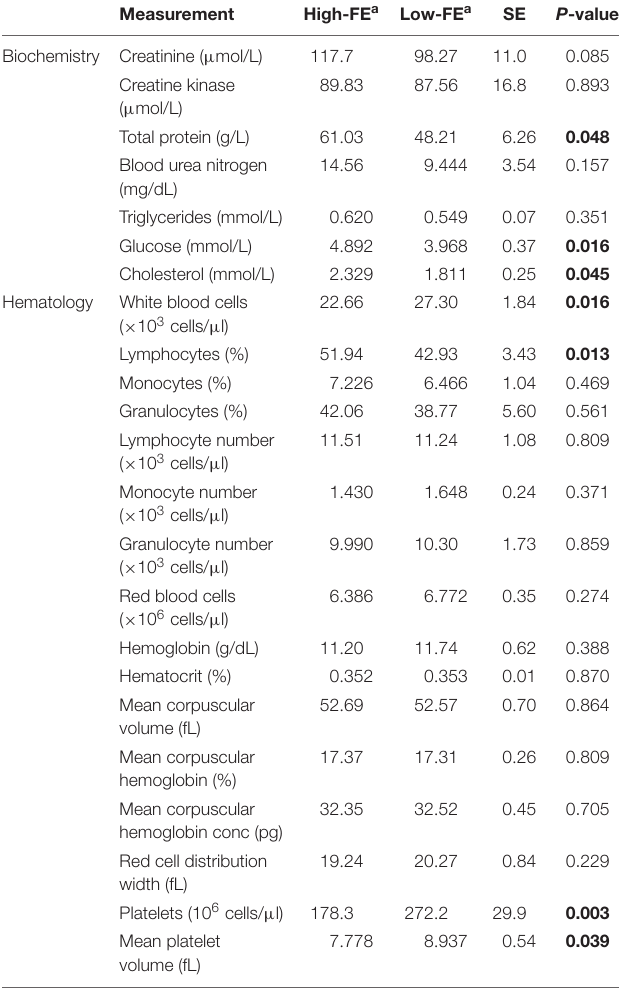
TABLE 2 | Effect of divergence in feed efficiency (FE) on biochemical and hematological parameters.